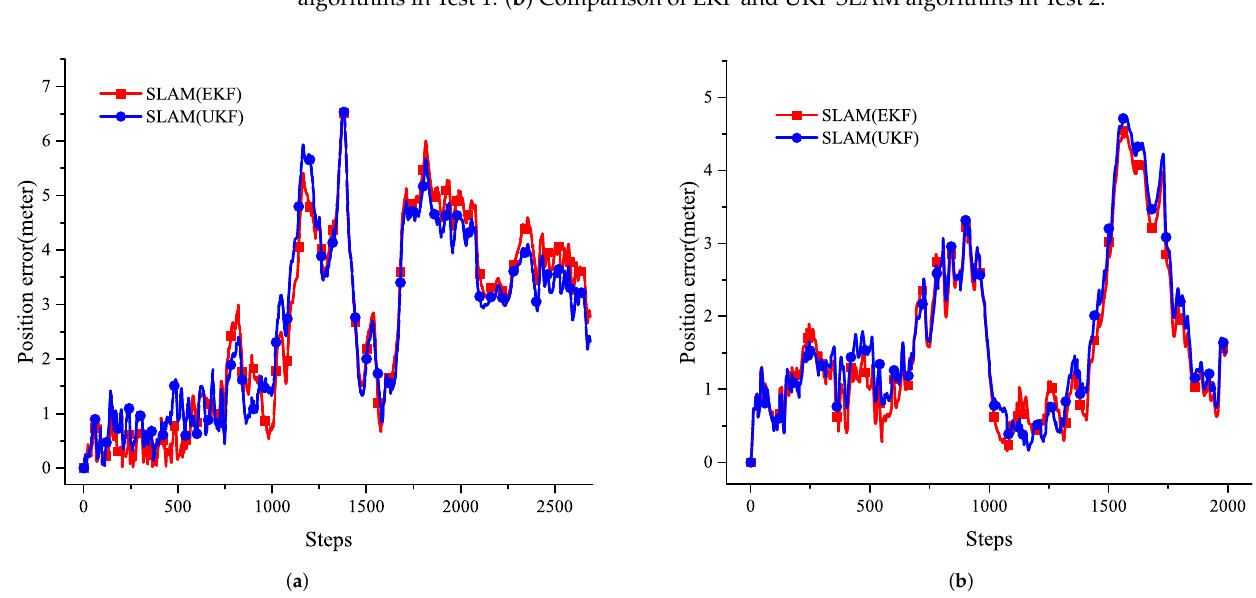
Figure 13. Comparison of EKF and UKF SLAM algorithms. ( a ) Comparison of EKF and UKF SLAM algorithms in Test 1. ( b ) Comparison of EKF and UKF SLAM algorithms in Test 2.